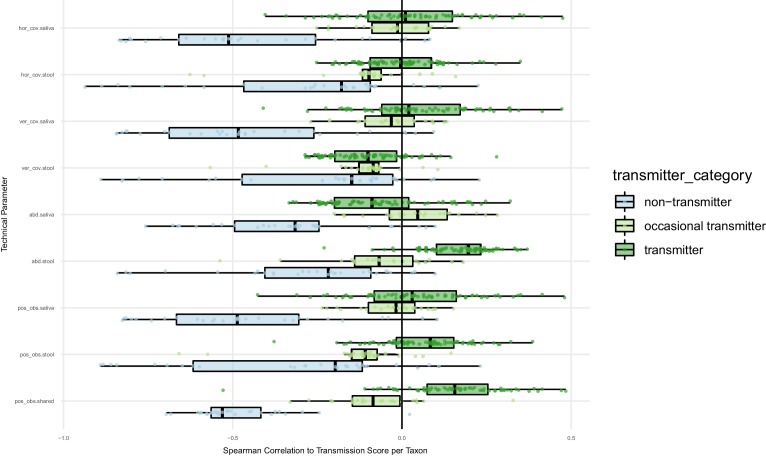
Oral-fecal transmission scores are independent of technical covariates.Spearman correlations of oral-fecal transmission scores (see Materials and methods) with putative technical covariates per taxon across subjects. On average, horizontal (breadth) and vertical (depth) genome mapping coverage did not correlate with transmission scores for transmitting taxa when viewed across subjects, and were anti-correlated for non-transmitting taxa (i.e., deeper coverage reinforced the negative signal for these taxa). In line with this, the total number of observed SNV positions in each site anti-correlated with transmission scores for non-transmitters, and mildly correlated for transmitters. Taxon relative abundance of transmitters in stool tended to correlate positively with transmission scores; arguably, this is a biological rather than a technical effect, as higher transmission rates coincide with higher fecal abundance of transmitted taxa. The same applies to intra-individually shared genome coverage which is likewise expected to coincide with oral-fecal strain overlap.